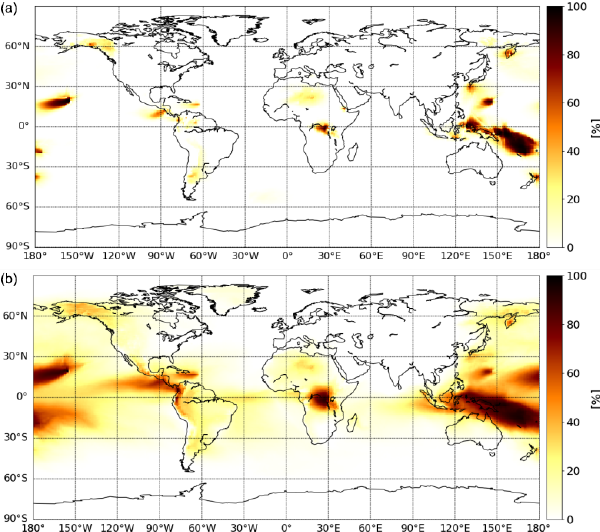
Figure 12. (a) The 2013 annual mean sulfur deposition from CARNALTI (in kilograms per square meter) and (b) its contribu- tion due to volcanic emissions (in